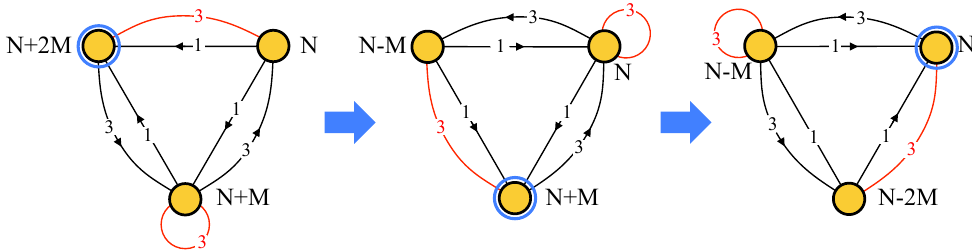
Figure 10. Three stages in the duality cascade for Y 1 ; 0 ( P 2 ) in the presence of regular and fractional branes. At every step we dualize the node with the highest rank, which is indicated in